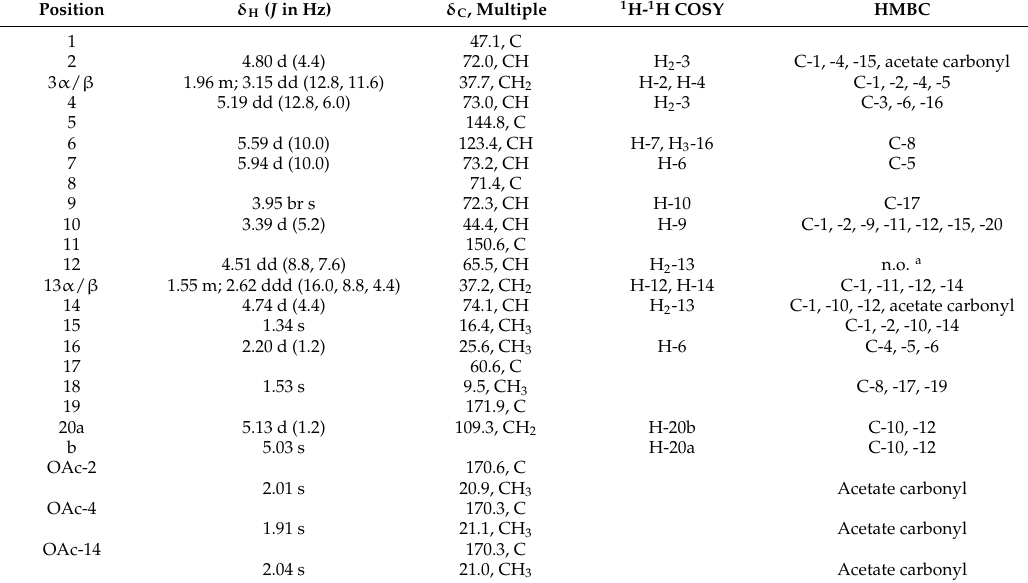
Table 1. 1 H (400 MHz, CDCl 3 ) and 13 C (100 MHz, CDCl 3 ) NMR data and 1 H- 1 H COSY and HMBC correlations for briarane 1